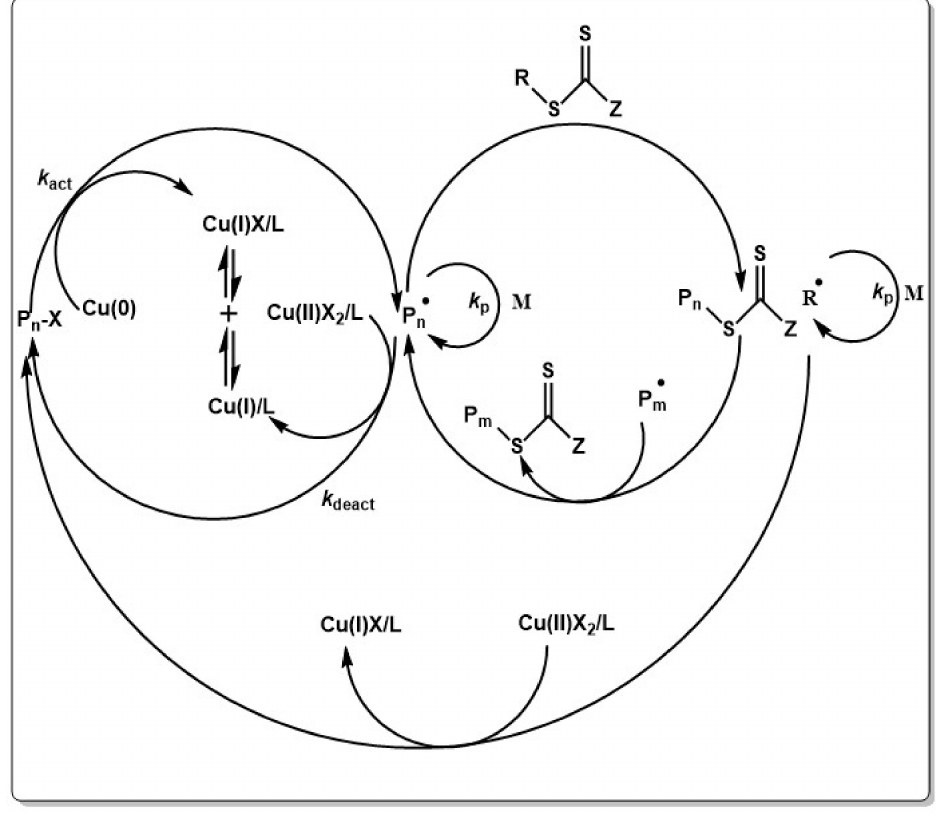
Scheme 10. Reaction mechanism for